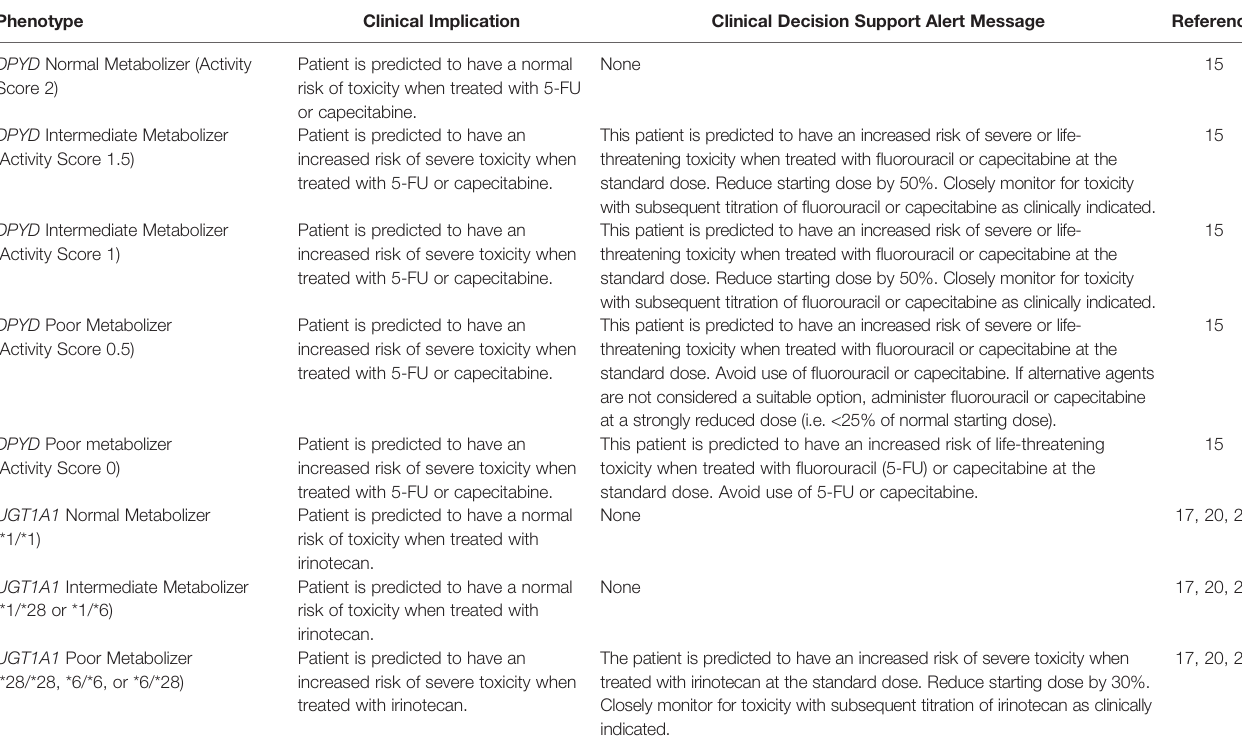
TABLE 3 | Genotype-guided clinical decision support for DPYD and UGT1A1